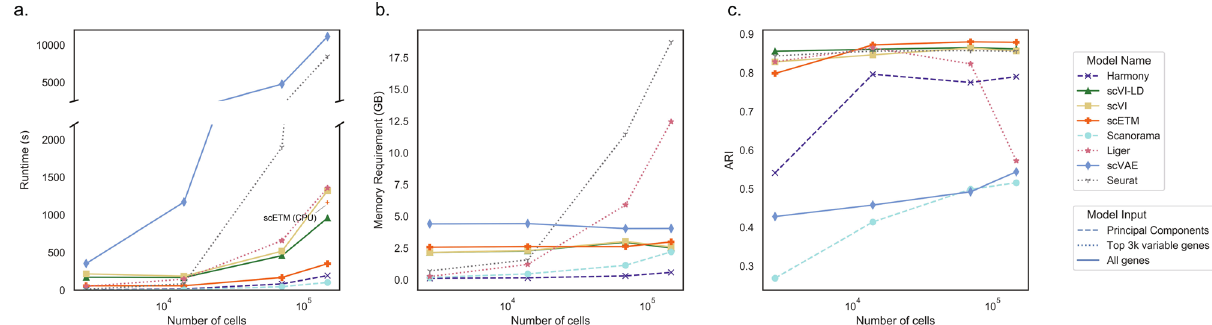
Fig. 3 Benchmark of the ef fi ciency and scalability of the seven scRNA-seq clustering algorithms. The line styles in the plot indicate model inputs. The number of genes was fi xed to 3000 in this experiment. We increased the number of cells randomly sampled from the combined AD and MDD dataset and evaluated the performance of each method in terms of: a runtime, b memory usage, and c adjusted rand index (ARI). The run-time of scETM on CPU is annotated on the left